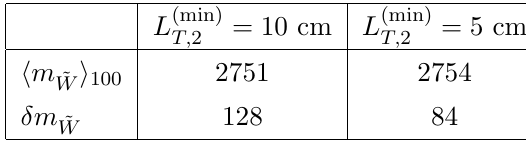
Table 3 . The mean of the peak position based on 100 data sets pp ! ~ W + ~ W (cid:0) +jets events, denoted as h m ~ i 100 , as well as the uncertainty in the Wino mass determination (in units of W